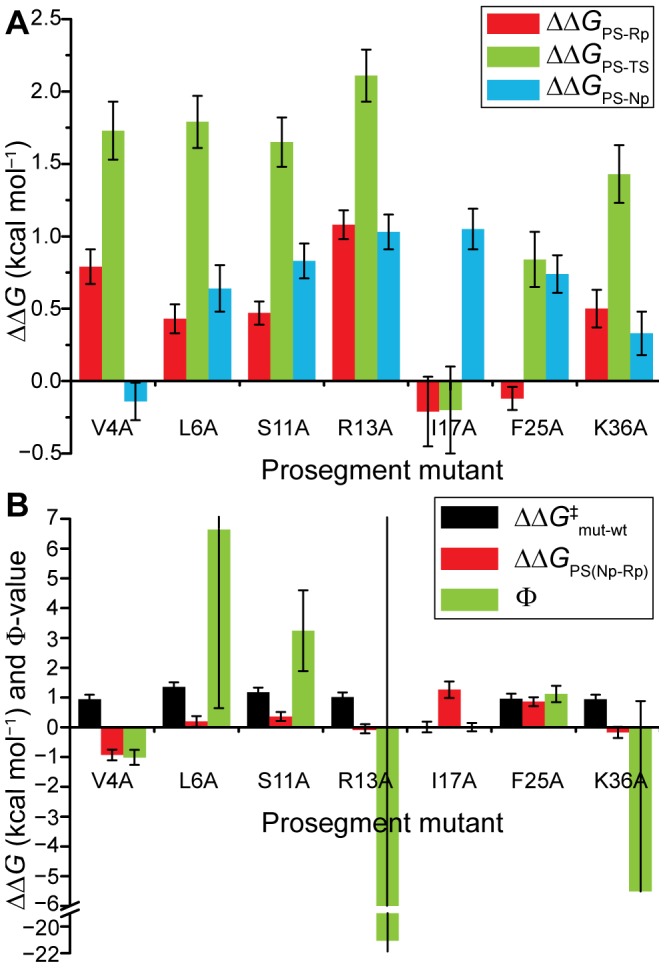
Changes in the PS-catalyzed folding energy landscape upon mutation of the PS peptide.(A) The changes in energy of each conformation were determined as changes in binding energies. (B) Φ-values calculated from the ratio of the changes in activation energy (ΔΔG‡) and free energy difference between PS-Np and PS-Rp (ΔΔGPS(Np-Rp)). Error bars show ± SD derived by propagation of errors.